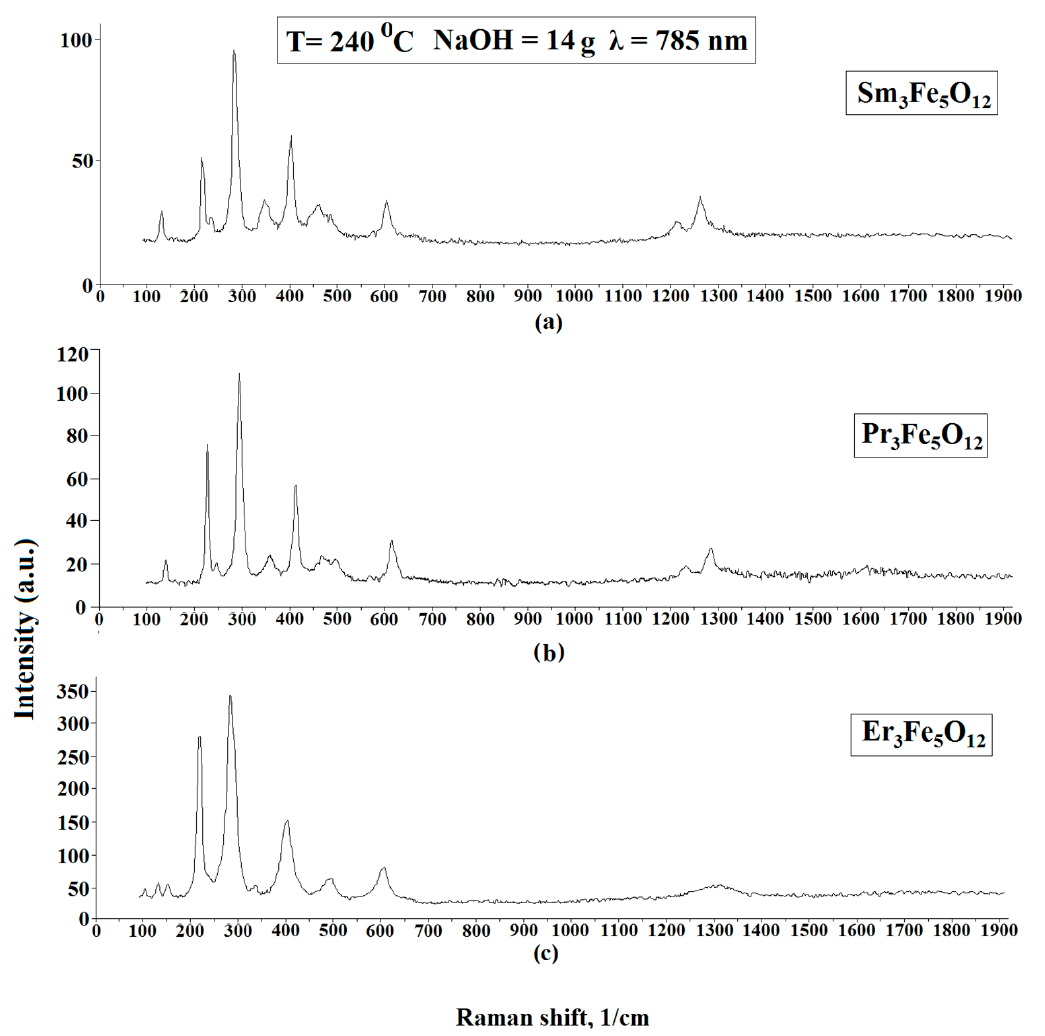
Figure 4. Raman spectra of Sm 3 Fe 5 O 12 ( a ), Pr 3 Fe 5 O 12 ( b ), Er 3 Fe 5 O 12 ( c ) powder samples.